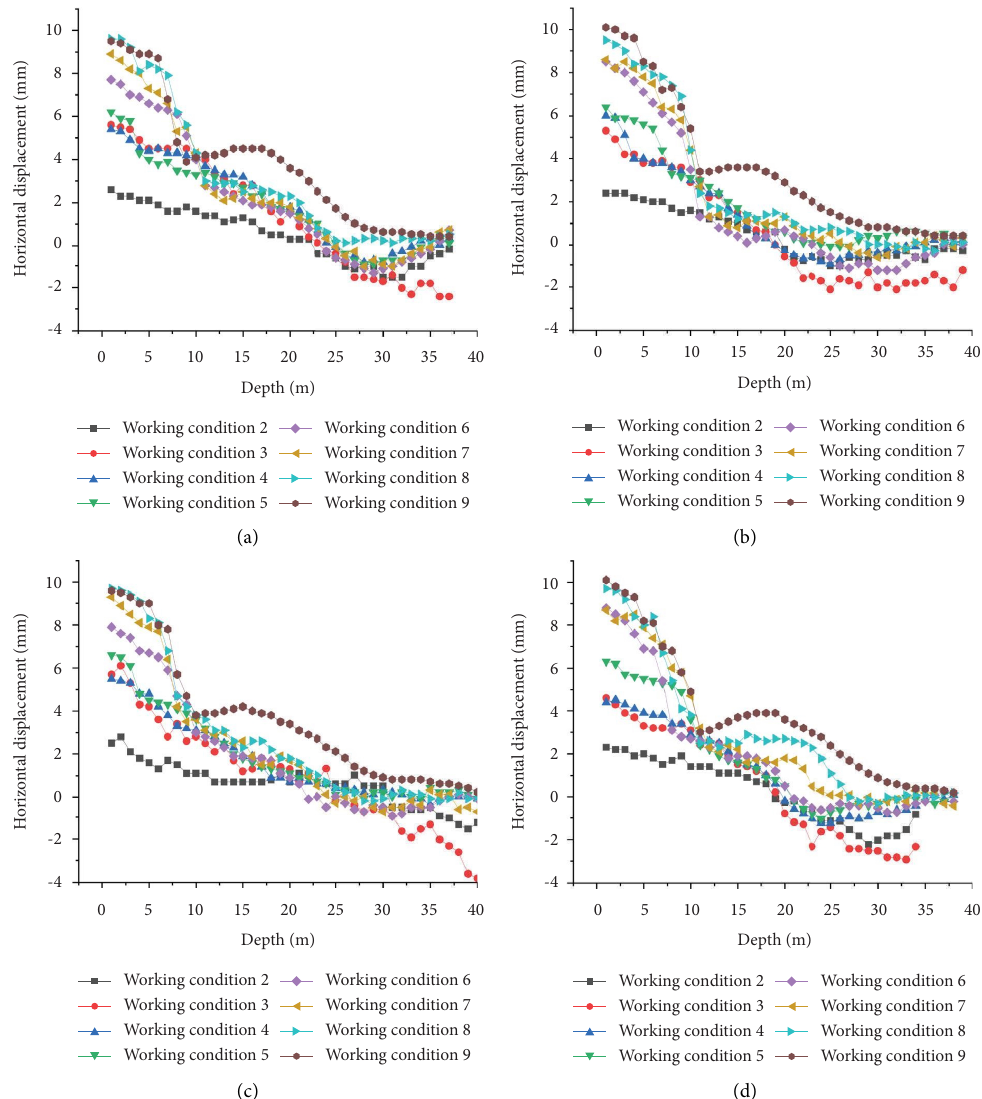
Figure 7: Monitoring data of the underground diaphragm wall. (a) No. 2 section. (b) No. 15 section. (c) No. 28 section. (d) No. 42